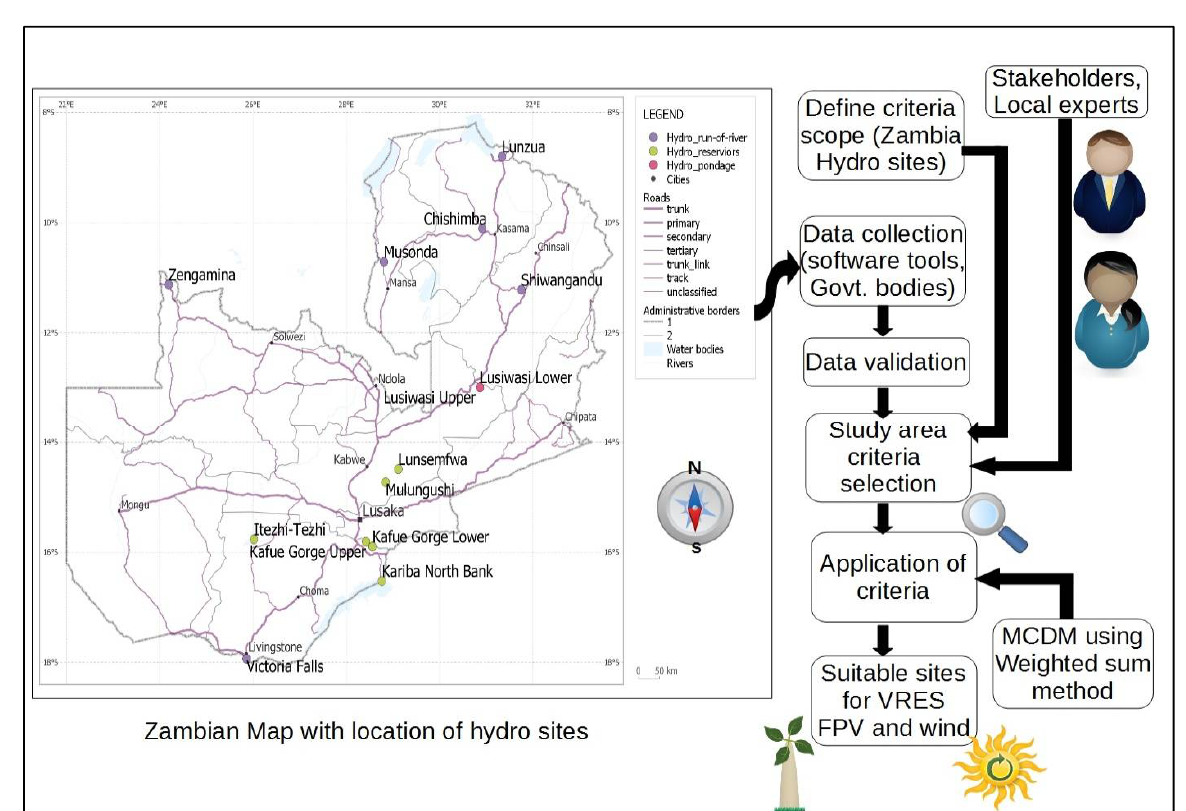
Figure 3. Diagram showing a proposed methodology flowchart of the study area shown.